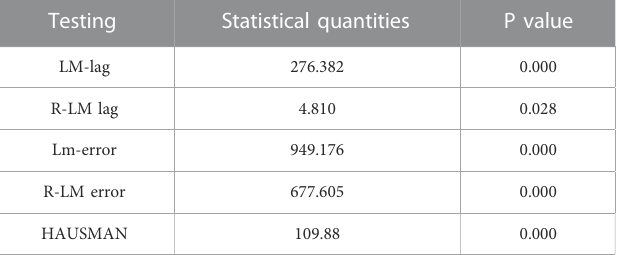
TABLE 5 Results of the LM and HAUSMAN tests.